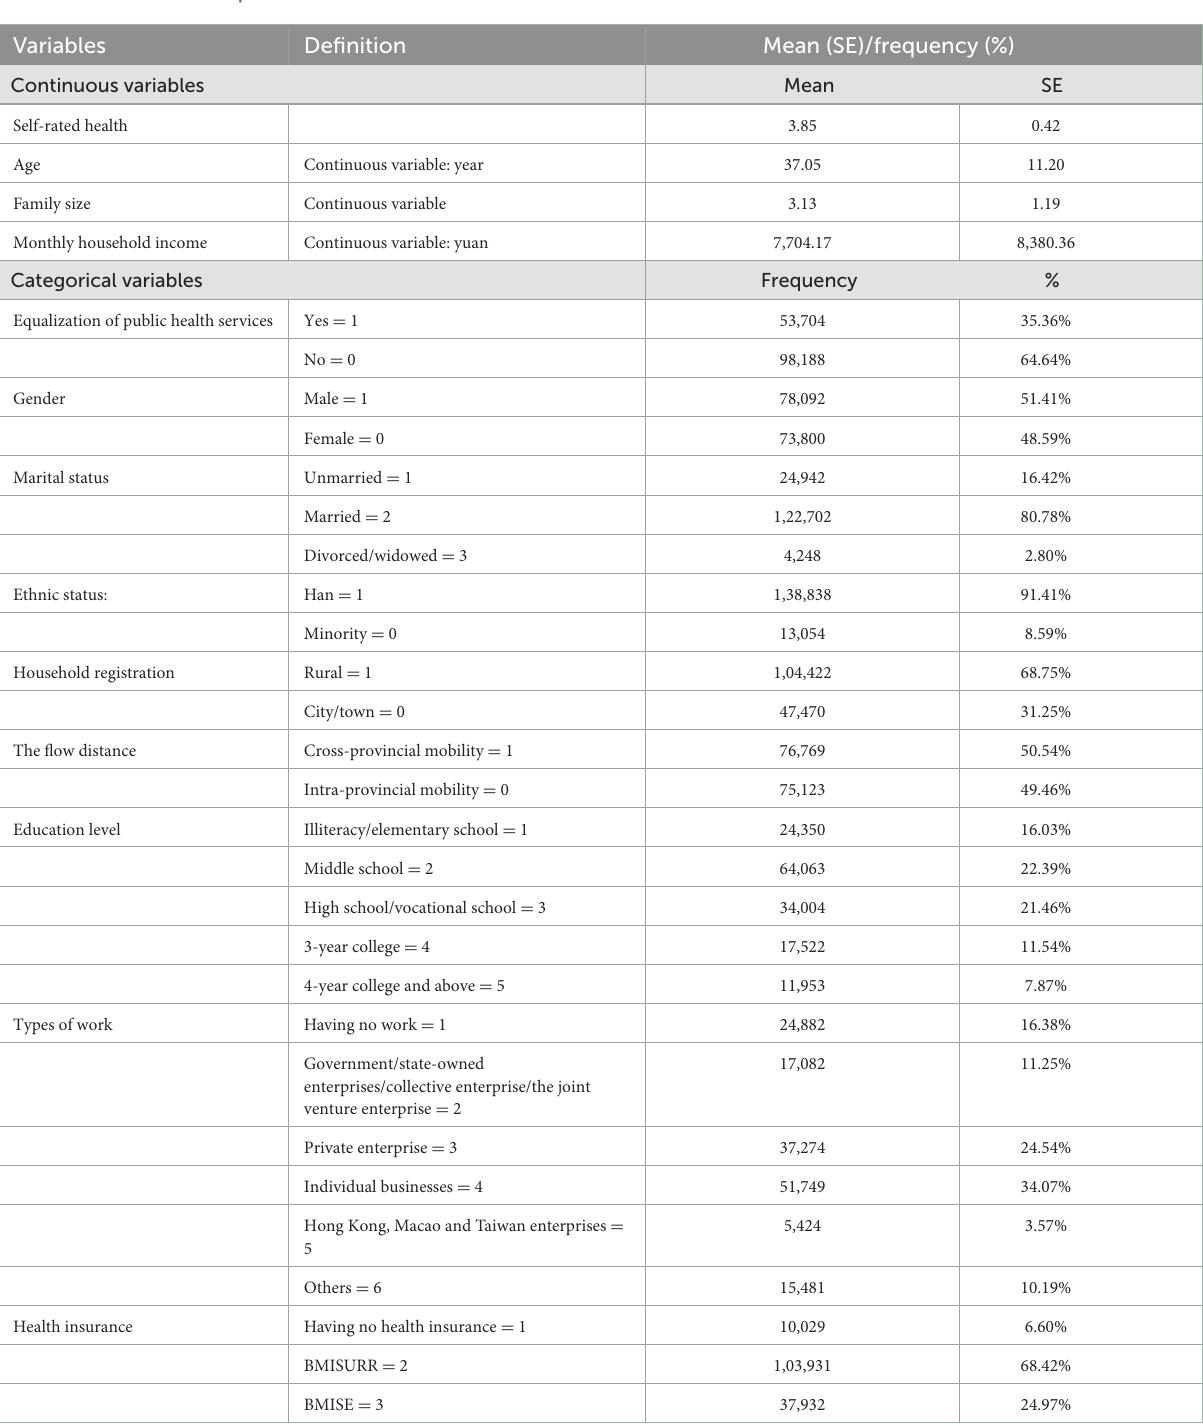
TABLE 2 The results of descriptive